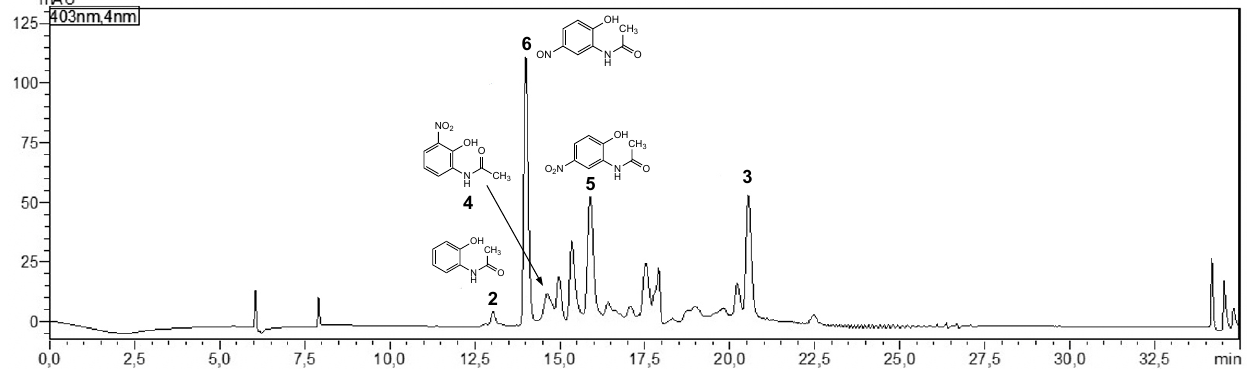
Figure 6. LC-UV chromatogram (403 nm) of an A. aminovorans culture supplemented with 2 and shaken during the first 2 days of culture. The medium contained some 2-amino- 3H -phenoxazin-3-one ( 3 ) as well as 2 , 4 , 5 , and 6